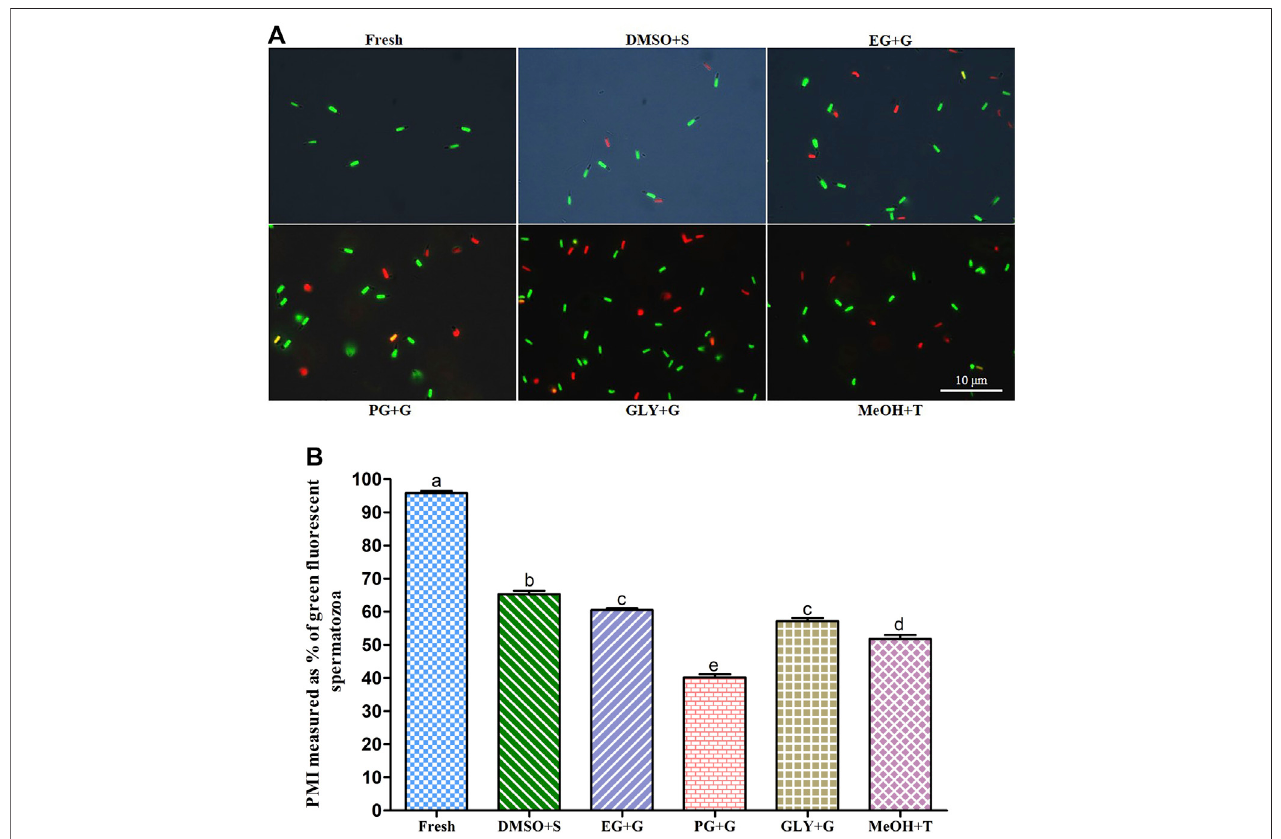
FIGURE 2 | Effects of saccharides (sucrose, glucose, and trehalose) on plasma membrane integrity (PMI) of post-thaw sperm. (A) SYBR14/PI-stained images of freshandcryopreservedsperm. (B) PMIvaluesofdifferenttypesofpost-thawsperm.Resultsarepresentedasmeanvalues±standarddeviation( n =10).DMSO+S:8% dimethylsulfoxide(DMSO)combinedwith3%sucrose(S),EG+G:8%ethyleneglycol(EG)combinedwith1%glucose(G),PG+G:6%propyleneglycol(PG)combined with 2% glucose (G), GLY + G: 2% glycerol combined with 3% glucose (G), and MeOH + T: 2% methanol (MeOH) combined with 4% trehalose (T). Signi fi cantly different levels ( p < 0.05) are denoted by different letters.